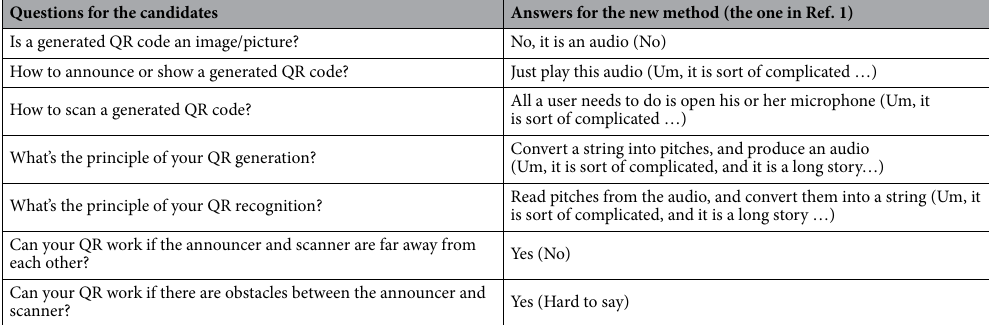
Table 8. Some key differences between the method in Ref. 1 and the new one.